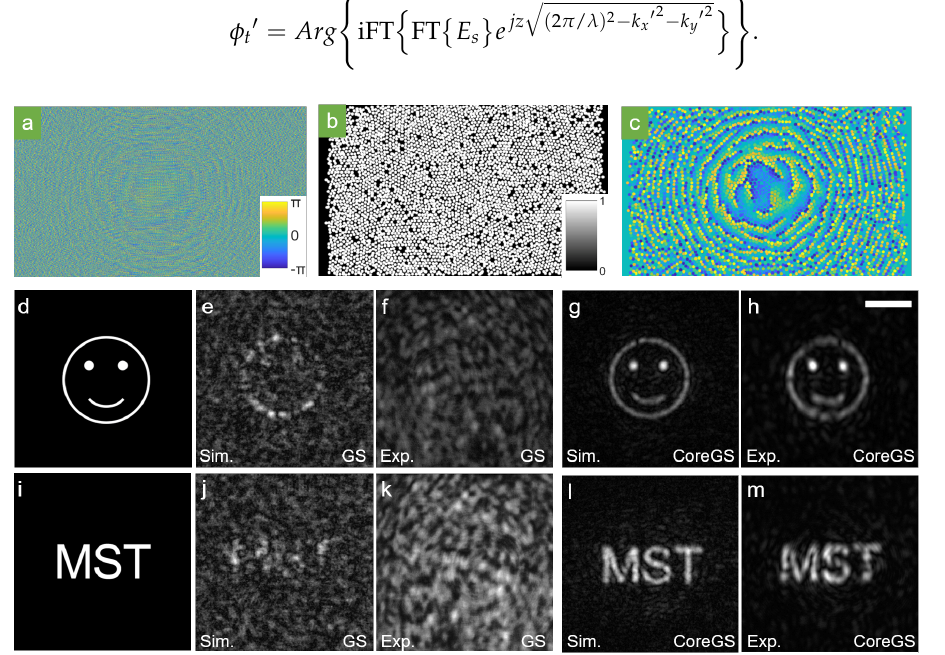
Figure 3. ( a ) Normal Gerchberg–Saxton (GS) algorithm calculated hologram which can generate a smile face light field in the region of interest (ROI). ( b ) Binary image of the core distribution on the MCF facet. ( c ) Tailored hologram for the smile face light field employing the CoreGS algorithm. ( d , i ) The targeted distal far-field intensity distribution at 600 µ m away from the MCF distal facet. ( e , j ) The simulated far-field intensity distribution employing the GS algorithm calculated hologram. ( f , k ) Experimental distal far-field intensity distribution through a MCF employing the GS algorithm calculated hologram. ( g , l ) The simulated distal far-field intensity distribution employing the Core-GS algorithm calculated hologram. ( h , m ) The experimental distal far-field intensity distribution through a MCF employing the Core-GS algorithm calculated hologram. The correlation coefficient between the experimental and simulated light field is 96.2% for the smiling face and 90.7% for the MST logo. The scale bar indicates a length of 20 µ